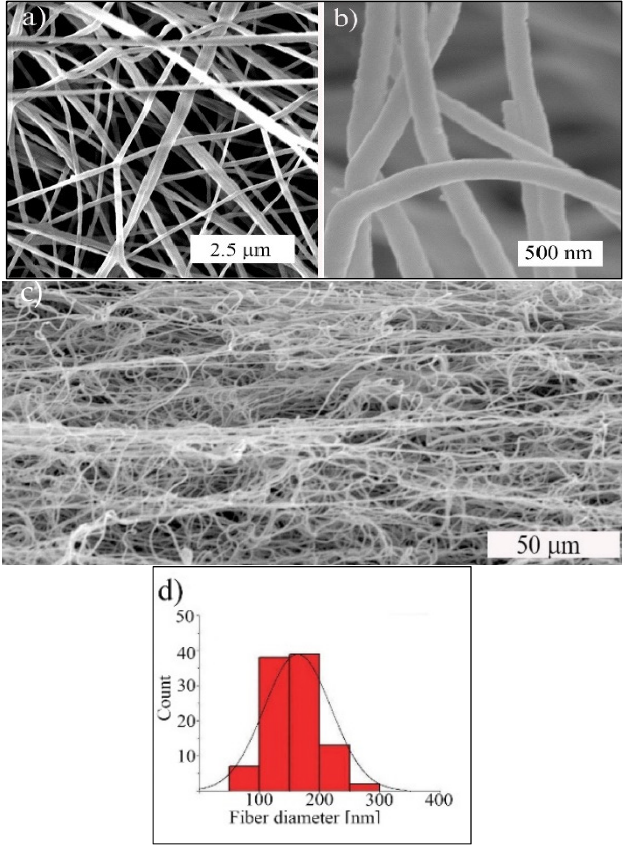
Figure 1. SEM micrographs of an electrospun PVDF membrane ( a ) shows a surface view of the membrane consisting of entangled PVDF fibres of different diameters, ( b ) a detailed view of the fibres, ( c ) membrane cross-section with a layered longitudinal fibre structure obtained by breaking it after cooling in liquid nitrogen, ( d ) the distribution of fibre diameters.